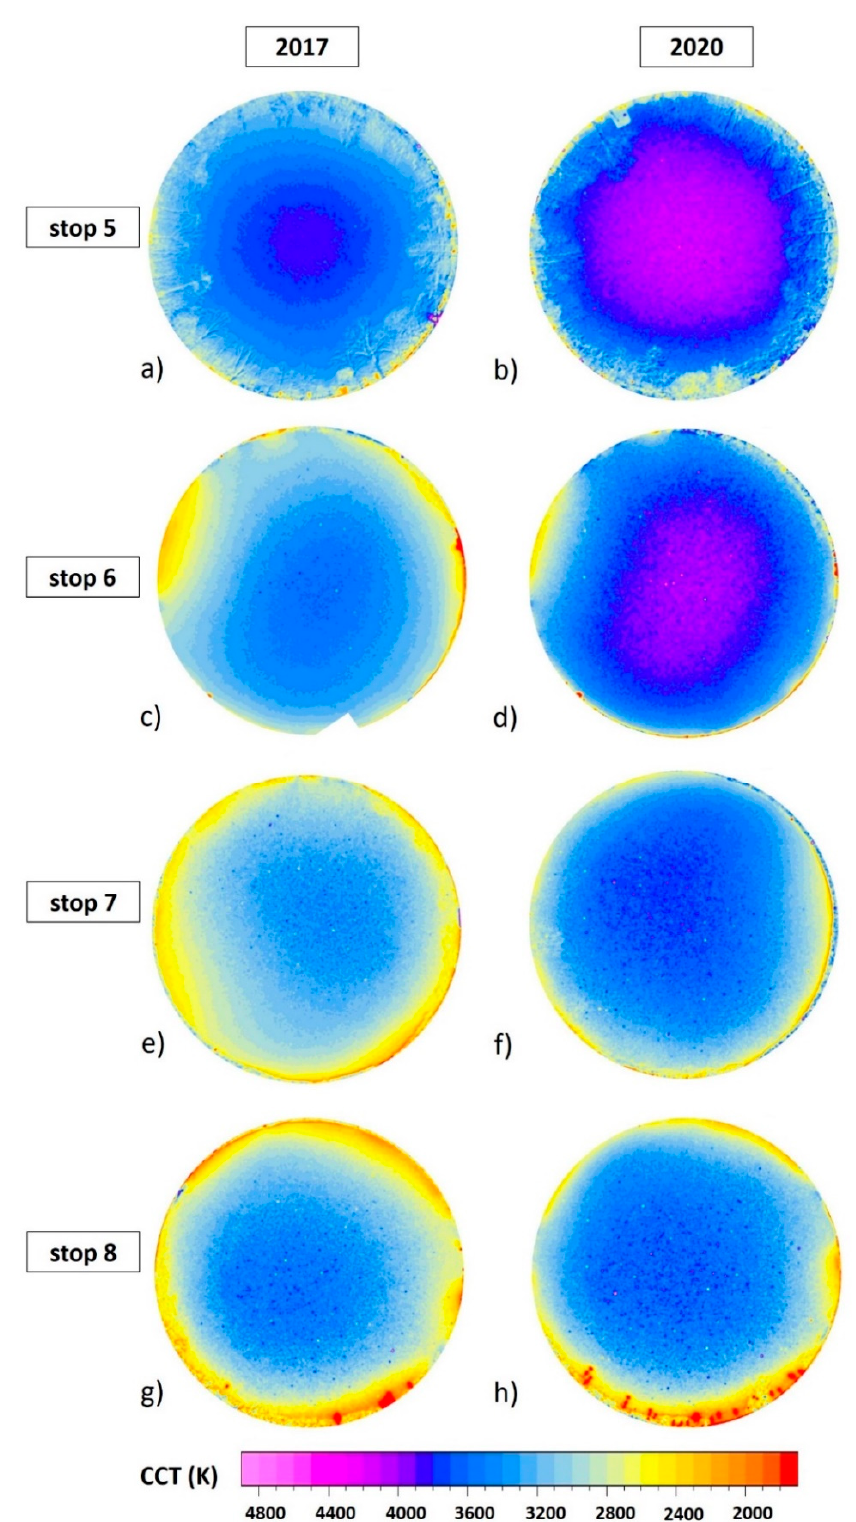
Figure A5. CCT maps for stops 5–8. ( a , c , e , g ) 2017 data, ( b , d , f , h ) 2020 data.